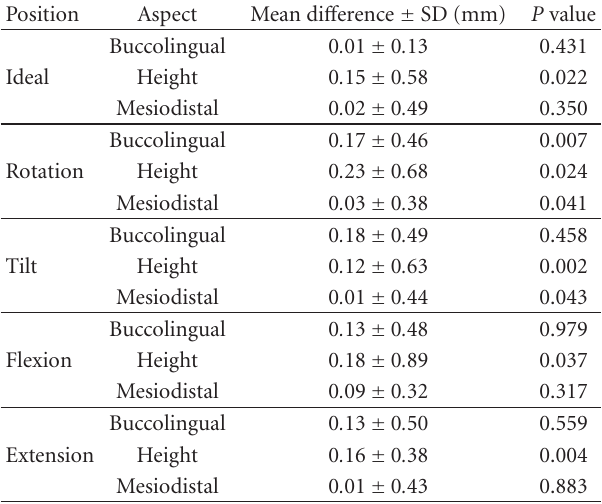
Table 3: Mean di ff erence between physical measurements and radiographic measurements in di ff erent positions, considering the measured